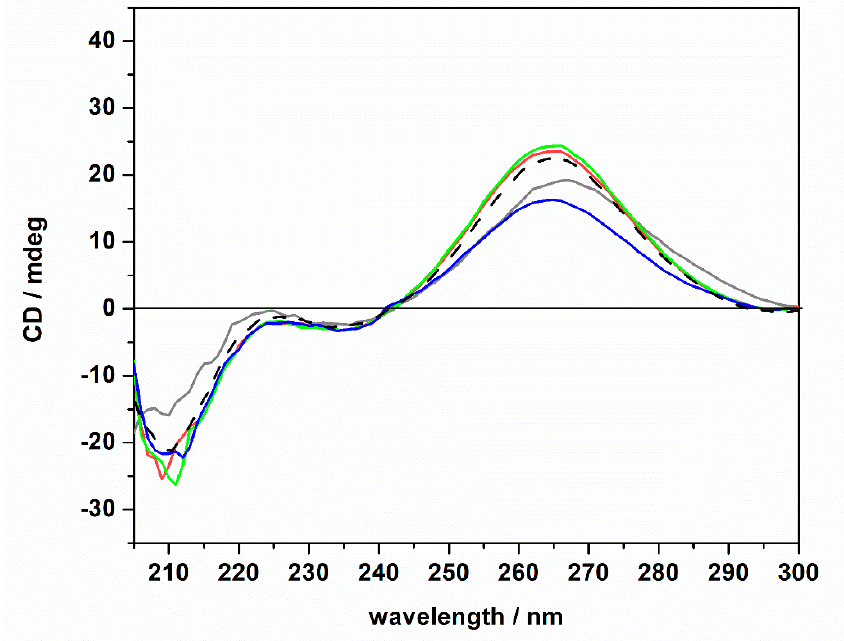
Figure 4. Circular dichroism spectra of a 20 μ M tRNA solution in the presence of 1 mM of ThT dissolved in 20 mM Tris-HCl buffer, 40 mM KCl, pH 6.9, in the absence (gray spectrum) and in the presence of 1 mM of MgCl 2 (red spectrum), MgSO 4 (blue spectrum), and Mg(ClO 4 ) 2 (green spectrum). For comparison, the CD spectrum of tRNA in neat buffer in the absence of ThT is also reported (dashed black spectrum).